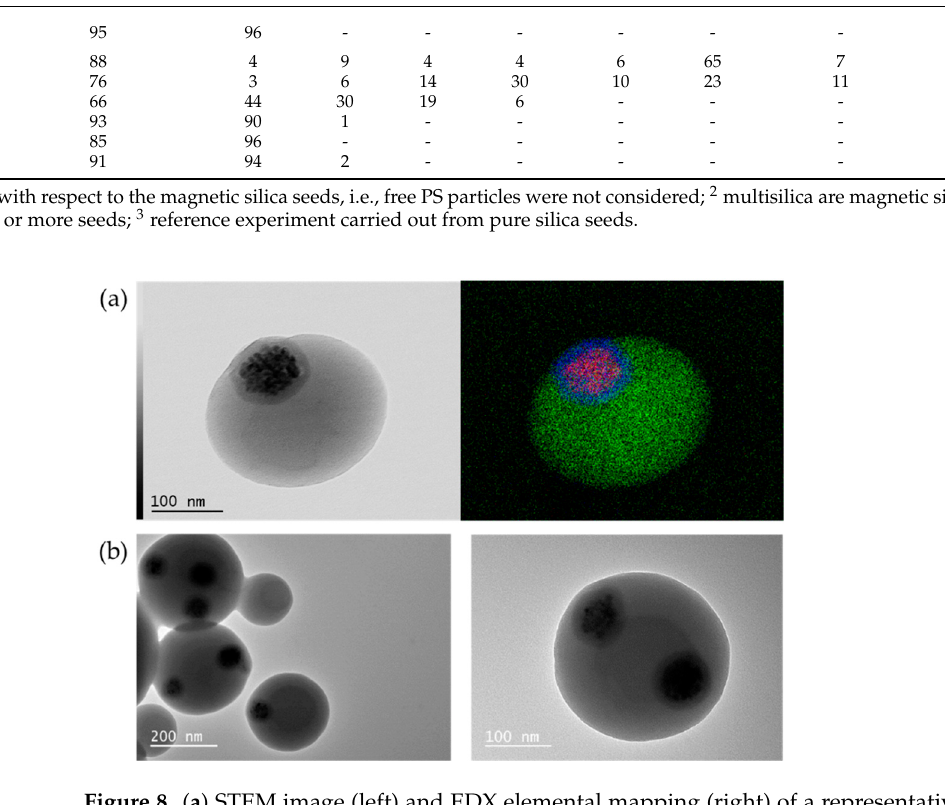
Figure 8. ( a ) STEM image (left) and EDX elemental mapping (right) of a representative magnetic silica/PS monopod (red, blue and green pixels represent iron, silicon and carbon, respectively) corresponding to the entry #3.6 of Table 3; ( b ) TEM images of PS particles with several magnetic patches as obtained after assembly of the magnetic monopods, corresponding to entry #3.6 of Table 3 collected at t = 30 min, using the optimal conditions as defined in entry #2.4 of Table 2.